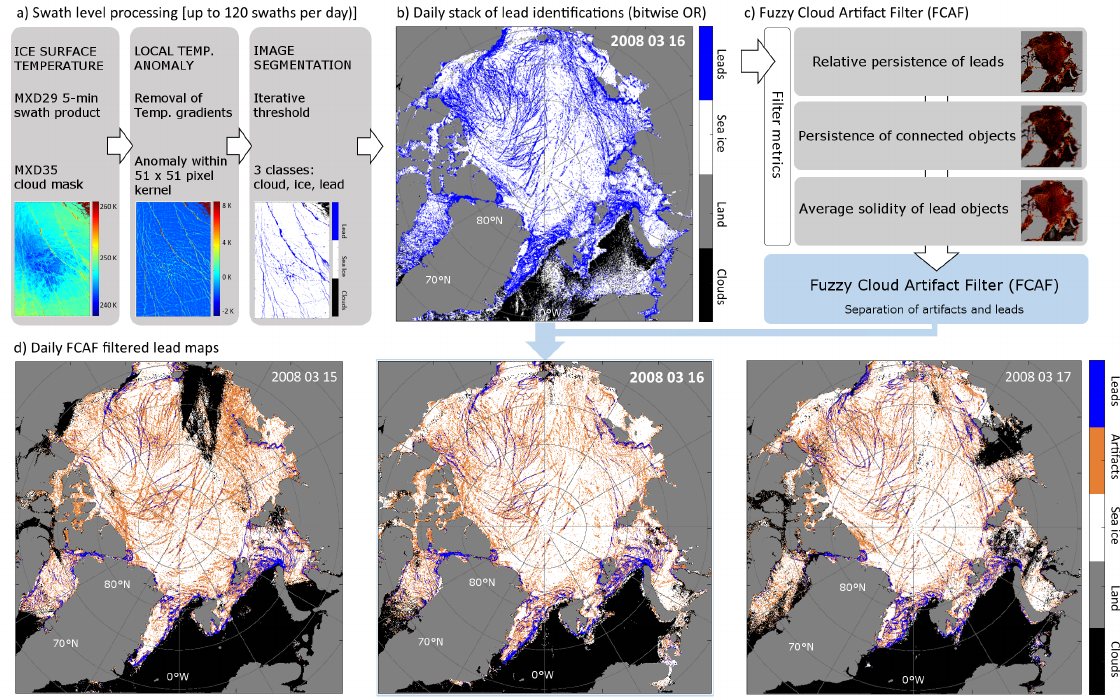
Figure 1. Retrieval of quasi-daily lead maps. ( a ) MODIS tile processing for 16 March 2008. After segmentation, the tile is projected to a common polar stereographic grid; ( b ) the resulting stack of daily potential lead identifications, resulting from a bitwise OR operation where leads from all tiles are combined; ( c ) Retrieval of temporal (lead pixel persistence, object persistence) and spatial (average solidity per lead pixel) metrics that are used in the Fuzzy Cloud Artifact Filter (FCAF) filter system [28] ); ( d ) FCAF filtered daily lead aggregate with categories cloud, land mask, sea ice, artifacts and true leads, three consecutive days 15 to 17 March